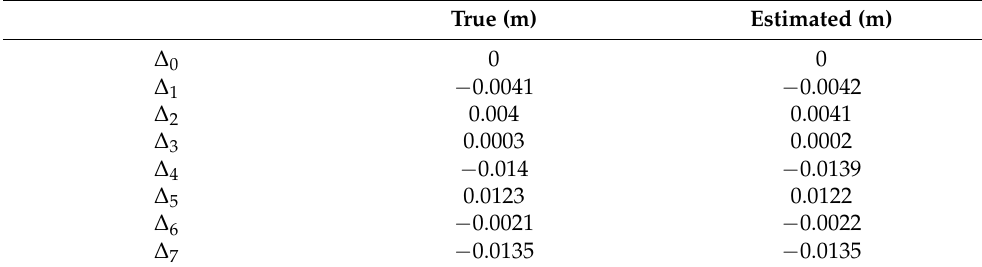
Table 4. Sensor location errors